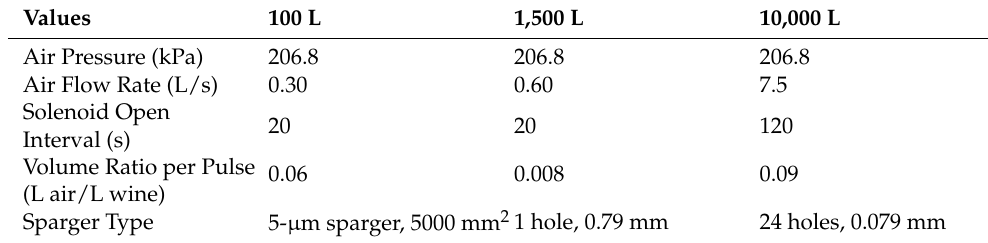
Table 1. Experimental